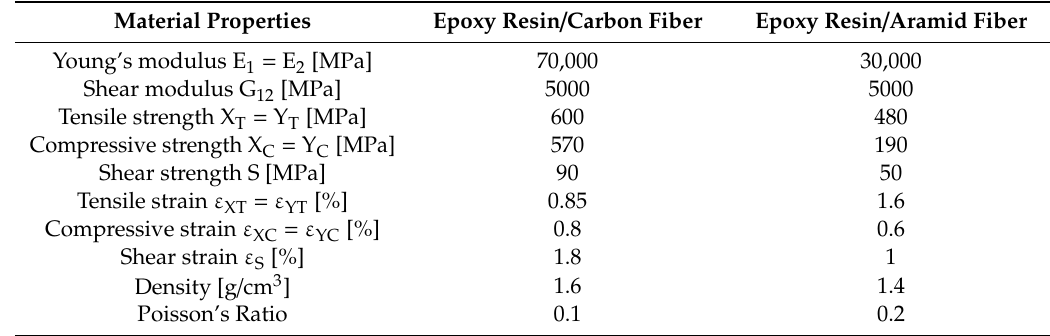
Table 4. Mechanical properties of epoxy composites reinforced by carbon and aramid fibers [58].